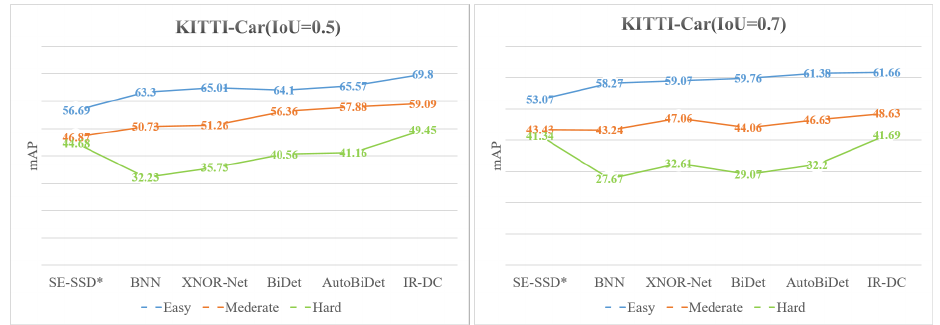
Figure 7. The results of different quantitative methods in the KITTI dataset